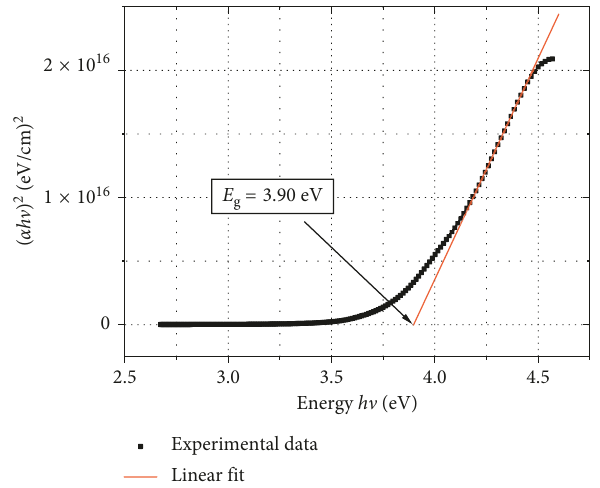
Figure 4: UV-Vis spectrum of qatranaite (black dots). Linear fit, according to equation (1), shows the energy gap width E g